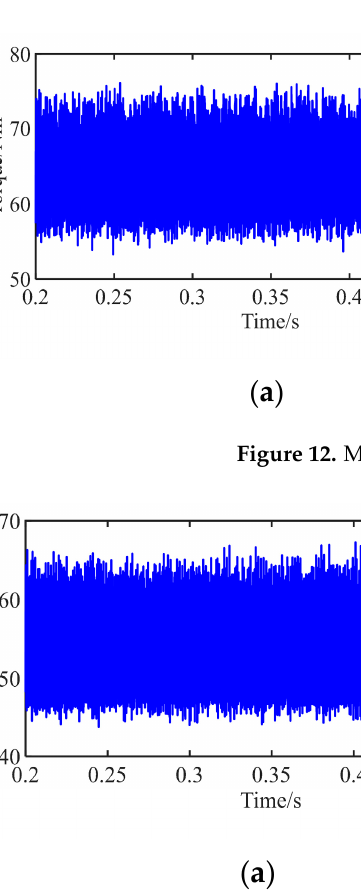
13 of 23 indicating that the mechanical system will be influenced by the harmonics of the electrical system during the operation of the DEDS, and that the DEDS presents a complex electro- mechanical coupling effect. ( a ) ( b ) Figure 11. The meshing force of the first gear pair in the single-motor drive mode: ( a ) time do- main; ( b ) PSD. 3.2. Dual-Motor Drive Mode From Figures 12b and 13b, in the electromagnetic torque PSD of the two motors in the dual-motor drive mode, in addition to the sixth harmonic component generated by its inverter’s nonlinearity, the sixth harmonic component generated by the nonlinearity of the other motor’s inverter also appears. This is because the two motors are coupled to- gether through the gearing system and affect each other in the dual-motor drive mode.